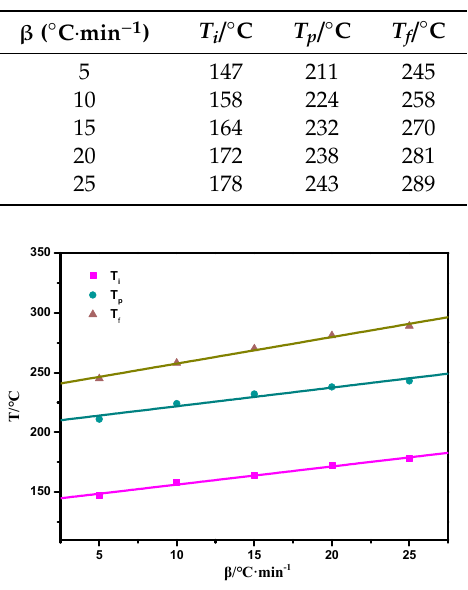
Figure 6. Curves of T versus β of the SPOSS-PBZ-E nanocomposites.